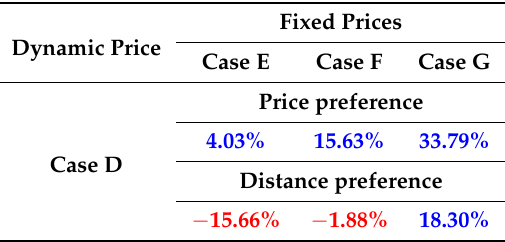
Table 12. Average charge price differences between dynamic Case D and the homologous fixed cases. The average prices paid by the EV users when Case D was used were 0.1925 e /kWh and 0.2414 e /kWh for the user price preference scenario and the user distance preference scenario, respectively. Blue color means that Case D is advantageous for the EV user, whereas the red color means that Case D is not advantageous for the EV user.